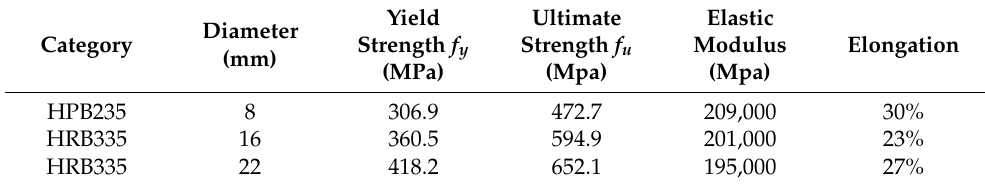
Figure 1. Specimen dimension and reinforcement (except for BCJ0 where no steel fiber is used): ( a ) BCJ0, BCJ1, BCJ2, and BCJ3 (the core area is equipped with stirrups); ( b ) BCJ4, BCJ5, and BCJ6 (the core area is not equipped with stirrups); ( c ) Reinforcement of specimen (unit: mm). Table 2. Mechanical properties of steel bars.